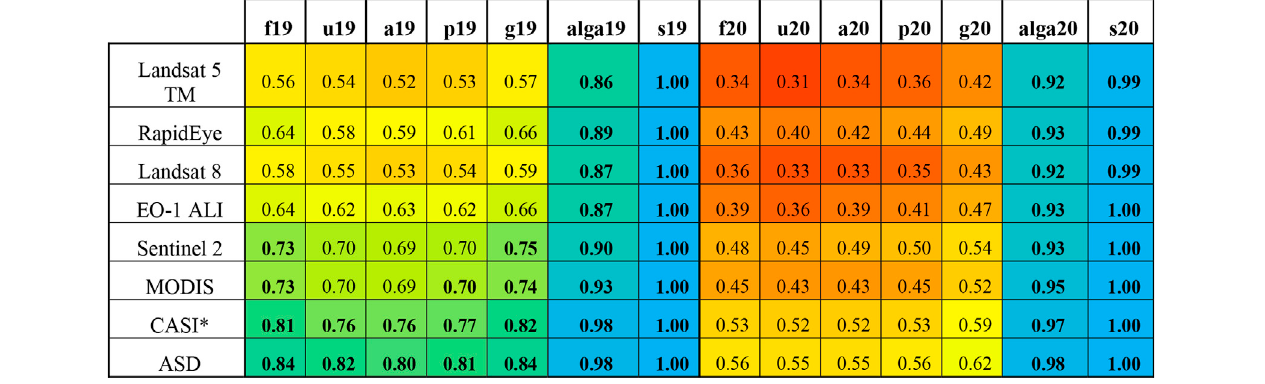
Table 3 . Although the NUSVC performed well on the leaf level spectroradiometer data, it resulted in 26 and 23% lower accuracy at the species level than FDSC and RBSVC, respectively.